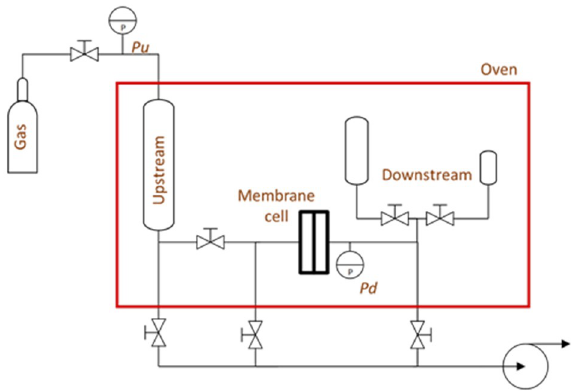
Figure 3. Constant volume-variable pressure apparatus. Table 1. Kinetic diameter and critical temperature